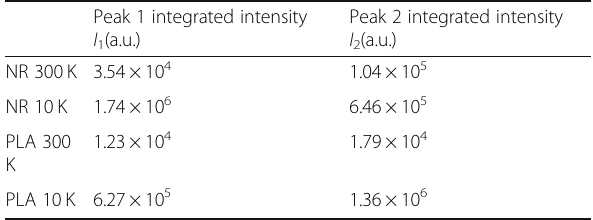
Table 1 The integrated peak intensities of the NR and PLA samples at 300 K and 10 K